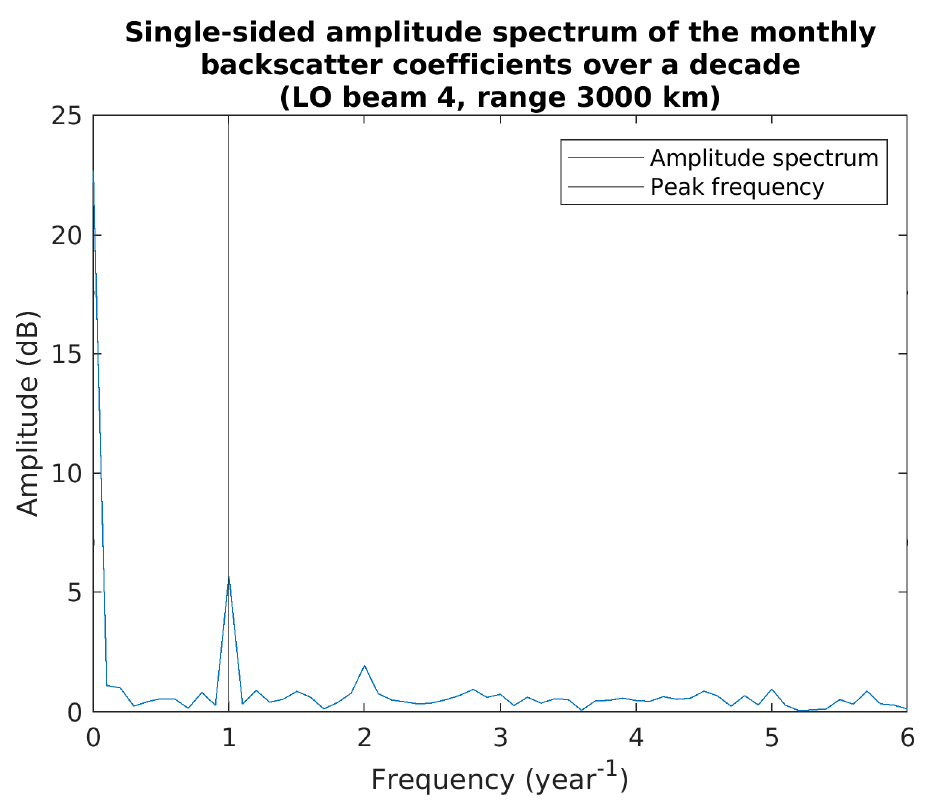
Figure 10. Single-sided amplitude spectrum from the FFT on the LO beam 4, range 3000 km data.